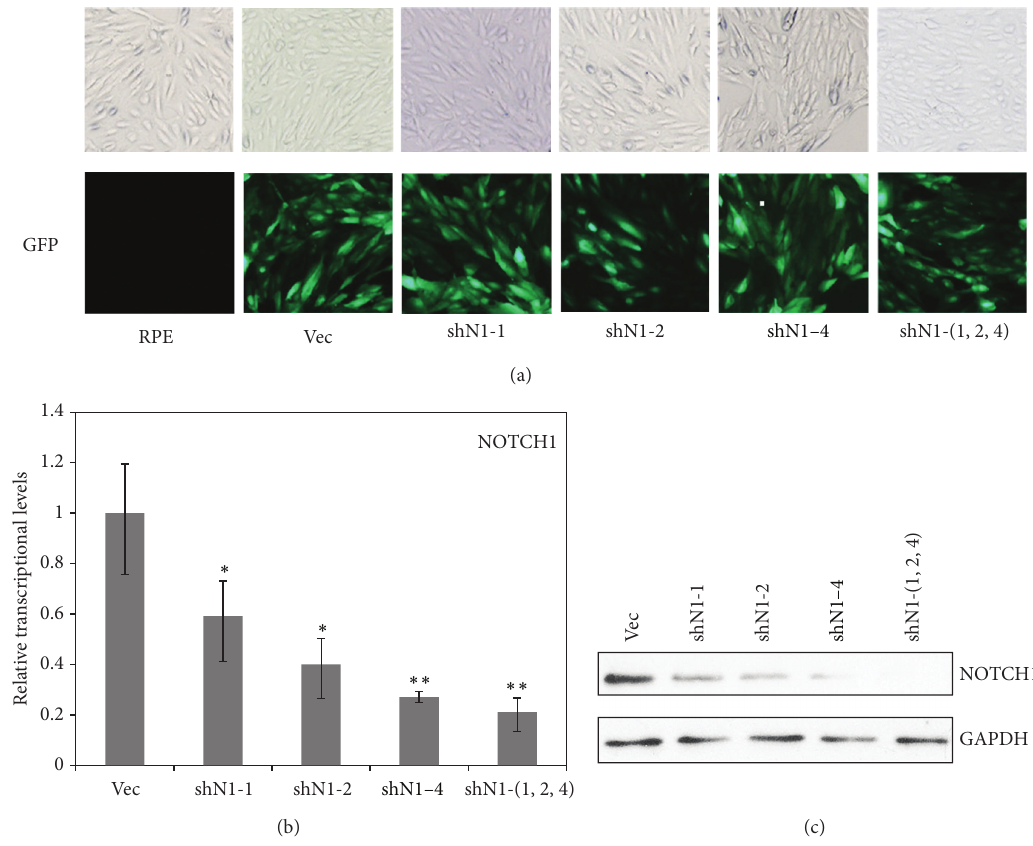
Figure 2: Notch signaling was blocked by lentiviral-based small hairpin RNA (shRNA) targeting NOTCH1. (a) Cell lines in which NOTCH1 was inhibited were established using the lentiviral system. Cells were successfully infected with shNOTCH1-lentivirus expressing GFP, which can be observed under a fluorescence microscope. (b) The knockdown efficiency of NOTCH1 was determined by real-time RT-PCR analysis. (c) The downregulation of NOTCH1 proteins was detected by Western blot analysis using GAPDH as an internal control. Data are expressed as means ± SD. ∗ 𝑃 < 0.05 versus vehicle and error bars represent at least two independent